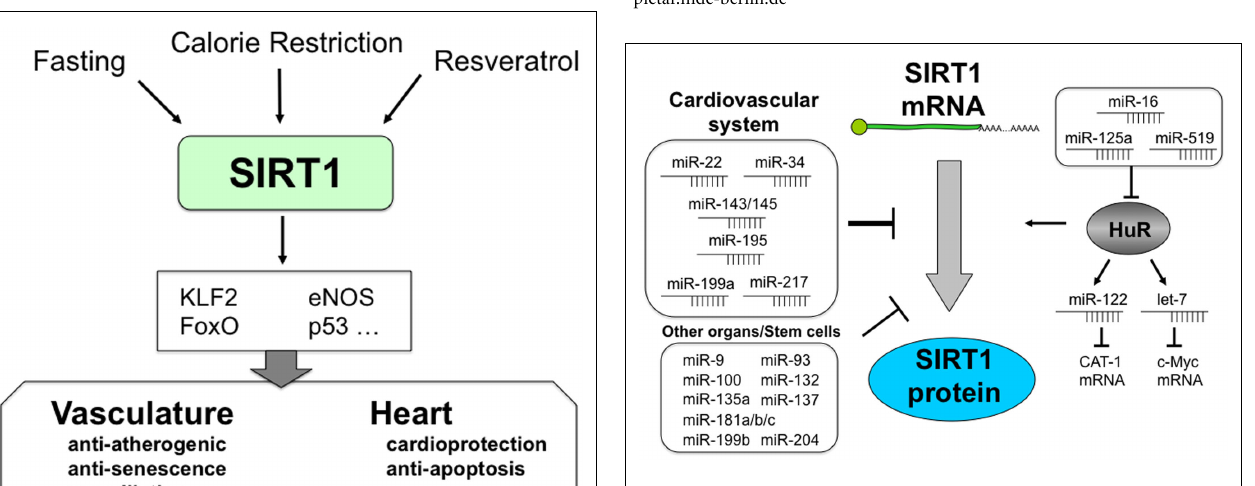
FIGURE 2 | Regulation of SIRT1 by miRNAs. Schema shows that miRNAs regulate SIRT1 expression and function directly or through HuR. miR-22, miR-34, miR-143/145, miR-195, miR-199a, and miR-217 are expressed well in vascular tissues and control SIRT1 protein. SIRT1 is regulated by more than 15 miRNAs. miR-16, miR-125a, and miR-519 decrease HuR expression. In contrast, HuR controls the post-transcriptional regulation of miRNAs such as miR-122 and let-7. Moreover HuR binds to the 3 (cid:2) UTR of SIRT1 and changes SIRT1 mRNA